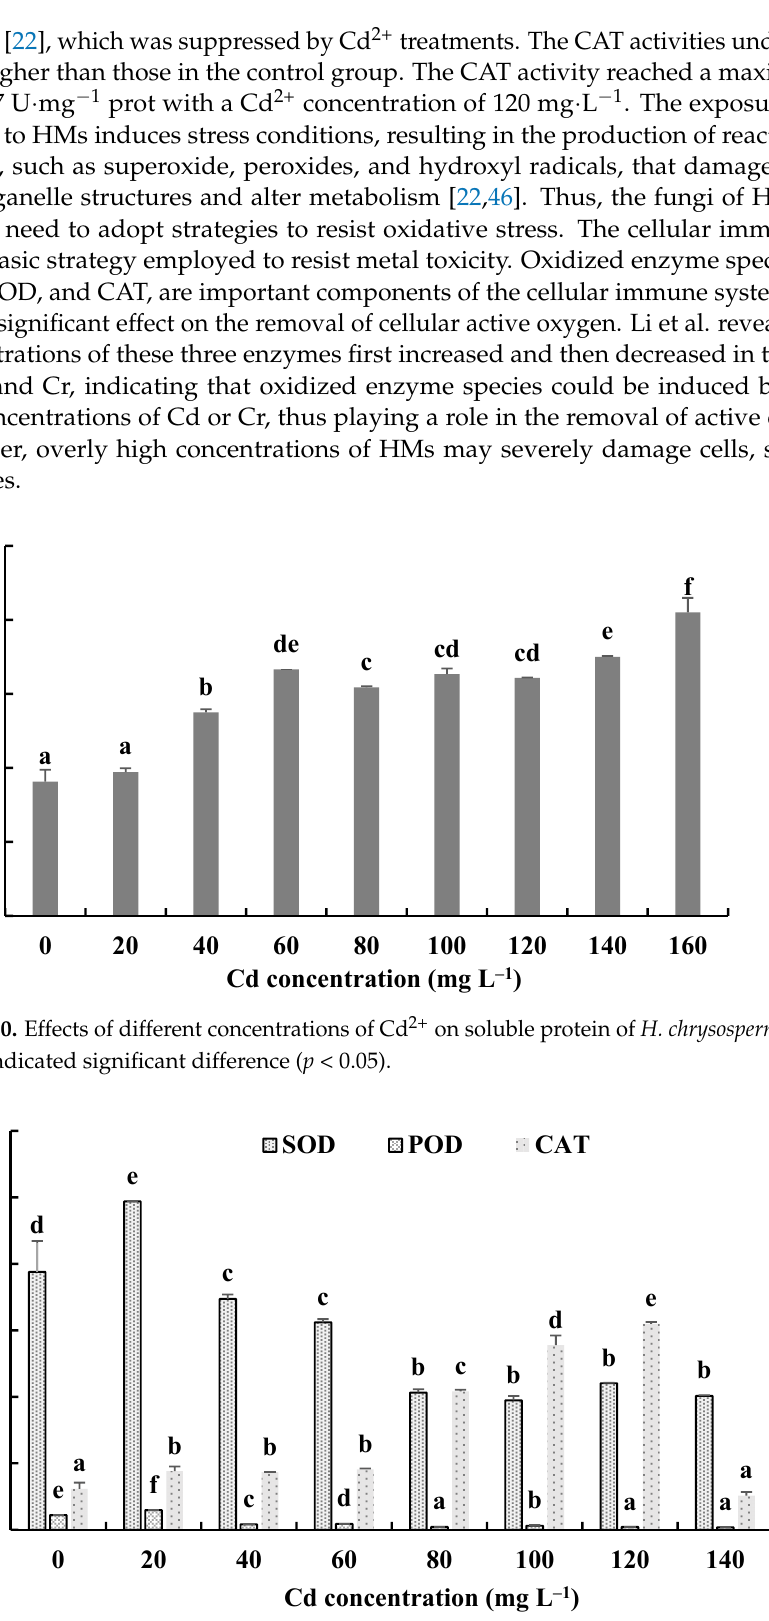
Figure 11. Effects of different concentrations of Cd 2+ on the activities of antioxidant enzymes of H. chrysospermus. Different letters indicated significant difference ( p < 0.05).